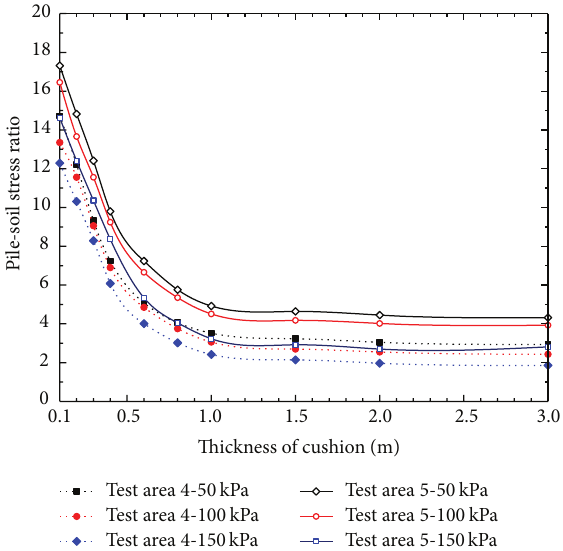
Figure 18: Effect of cushion thickness on pile-soil stress ratio